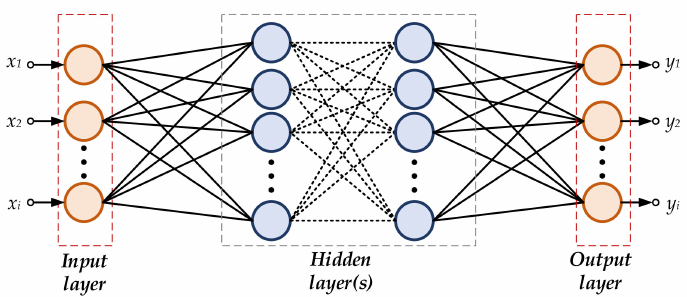
Figure 1. The basic architecture of the BPNN.